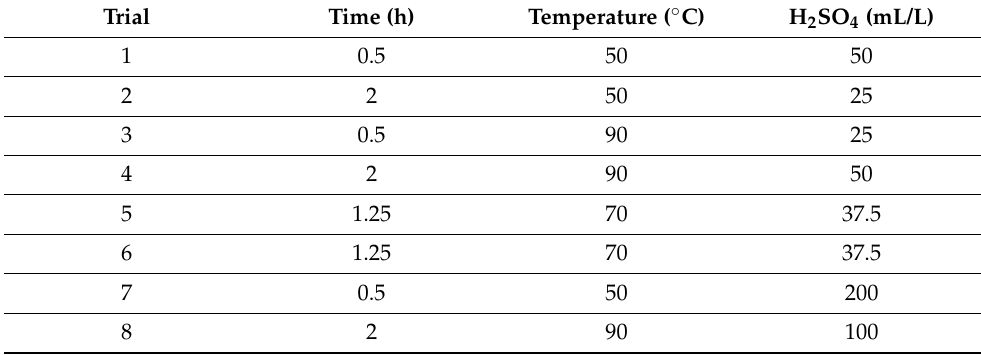
Table 5. Test conditions for sulfuric acid trials.